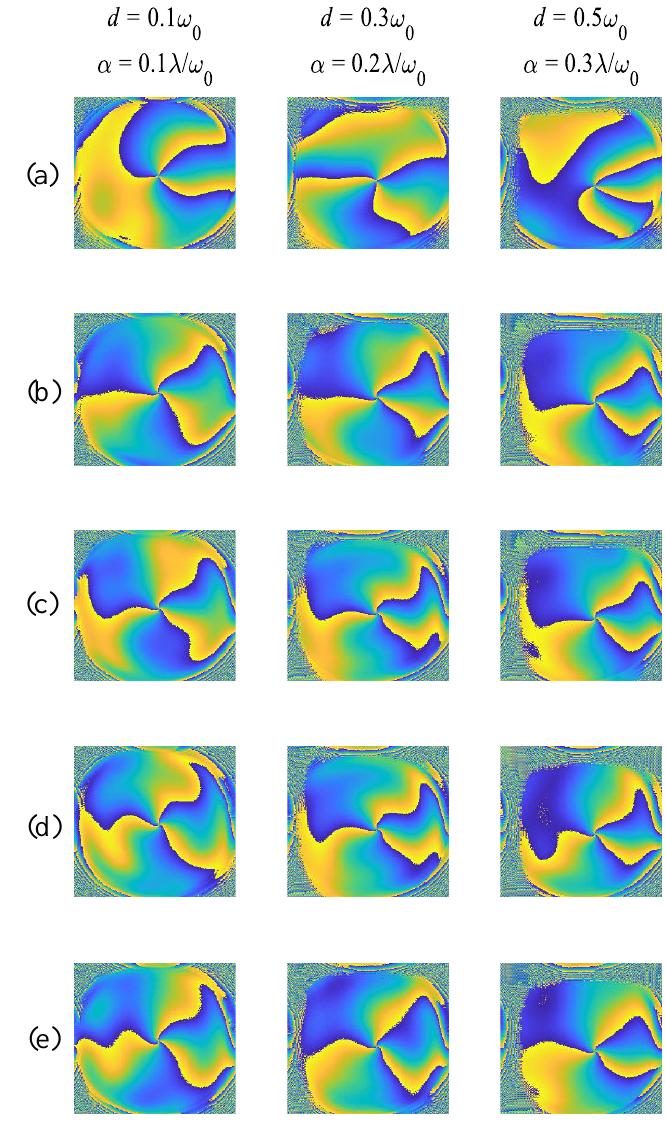
Figure 7. Comparison of results of phase recovery performed under different channel conditions: ( a ) before phase recovery; ( b ) MRWF algorithm; ( c ) WF algorithm; ( d ) TWF algorithm; ( e ) RWF algorithm.